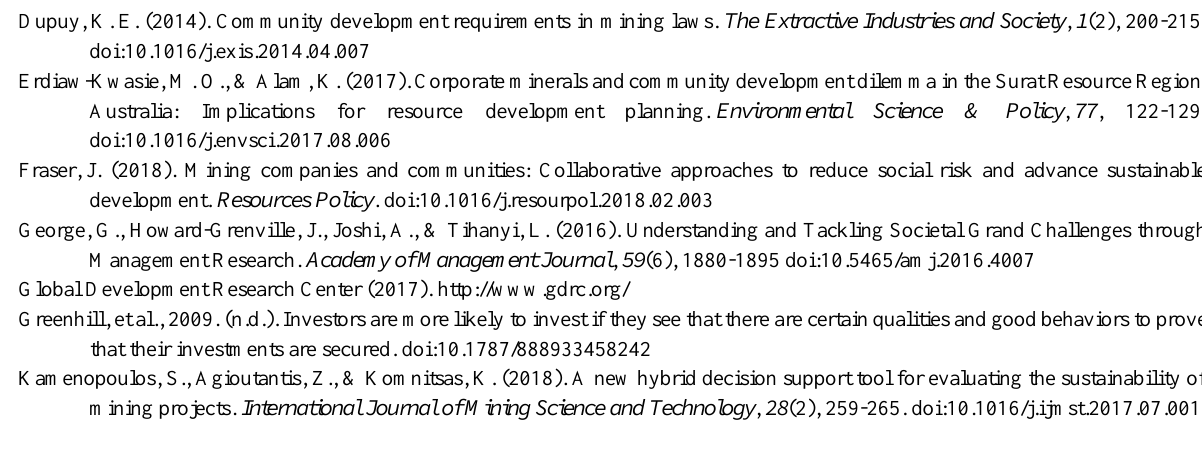
Table 3 summarizes the respondents’ answers as to the impact of Social Development and Management Programs to education, health, social and cultural and economic aspects of the host communities. The responses show uninformity as to the level